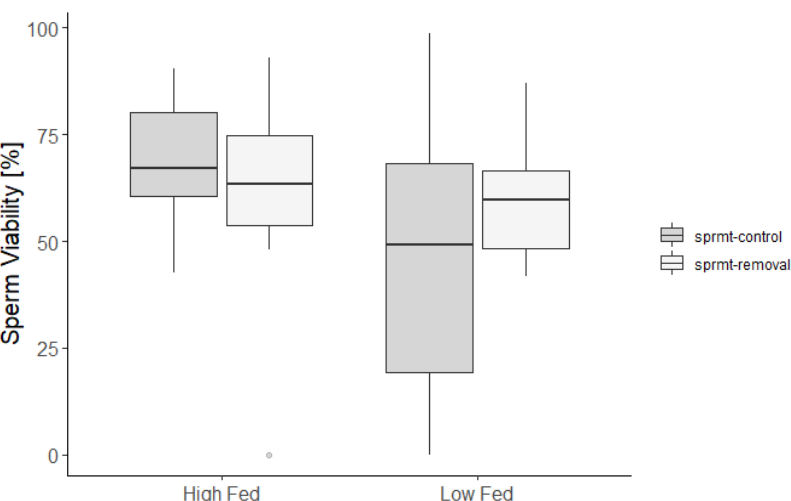
Figure 3. Proportion of live cells in the ejaculate of males exposed to high and low feeding treat- ments (high-fed and low-fed), with and without experimental spermatophore removal (respec- tively, sprmt-control and sprmt-removal).